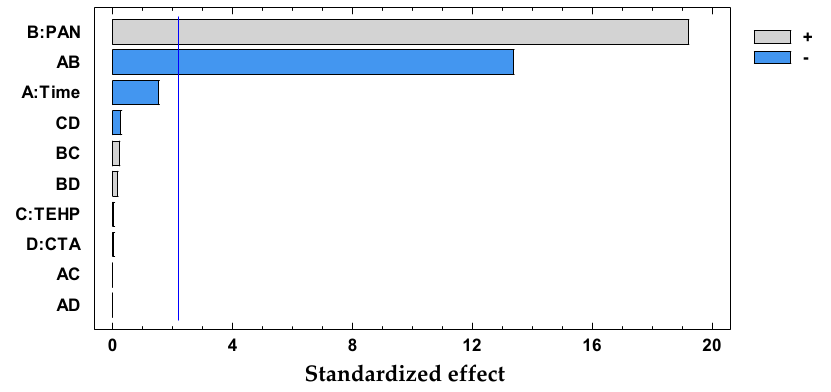
Figure 11. Desirability pareto chart after DoE analysis for the system PAN–Cd(II). Table 6. Analysis of variance (ANOVA) results for the system PAN-Cd(II).